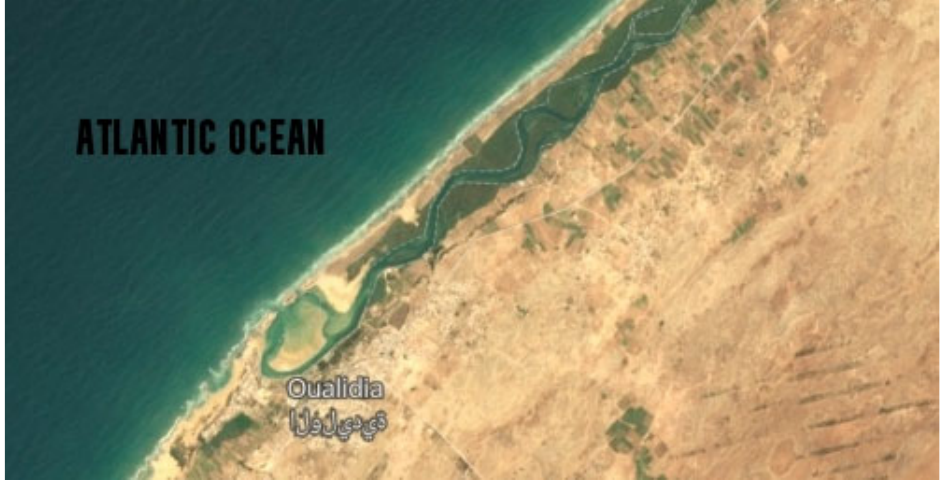
Figure 2. Oualidia lagoon, North West of Morocco (N 32.74675, W 9.036667), (Image GeoEye from Google Earth, 2022). Table 1. Physical and chemical data measured in waters of Marchica and Oualidia lagoons at the time of sampling.